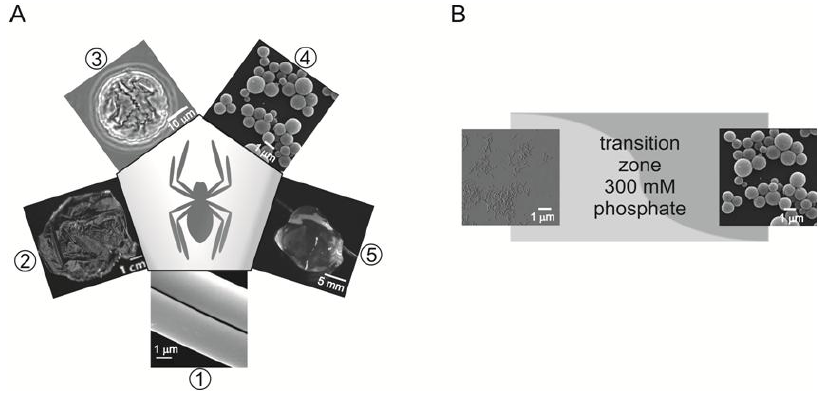
Figure 4. Processing of recombinant spider silk proteins into various non-natural shapes; ( A ) Apart from the natural MA silk fiber (1) produced by a spider, other morphologies such as films (2), capsules (3), microspheres (4) and hydrogels (5) can be prepared from recombinant spidroins; ( B ) Control over the formation of nanofibrils and microspheres: At low potassium phosphate concentrations nanofibrils self-assemble, while at high salt concentrations microspheres are formed. At intermediate phosphate concentrations the two species coexist